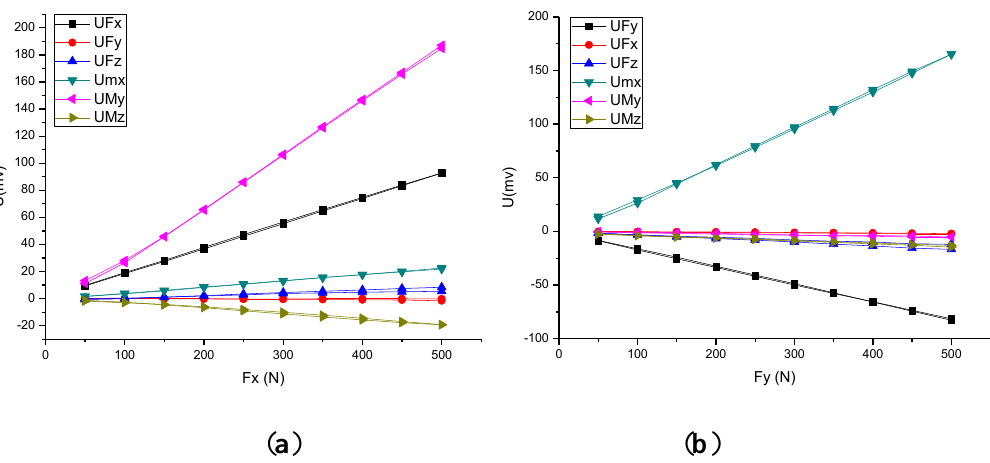
Figure 6. Selected input force and output voltage calibration curve of the sensor: ( a ) F direction, ( b ) F direction. Y